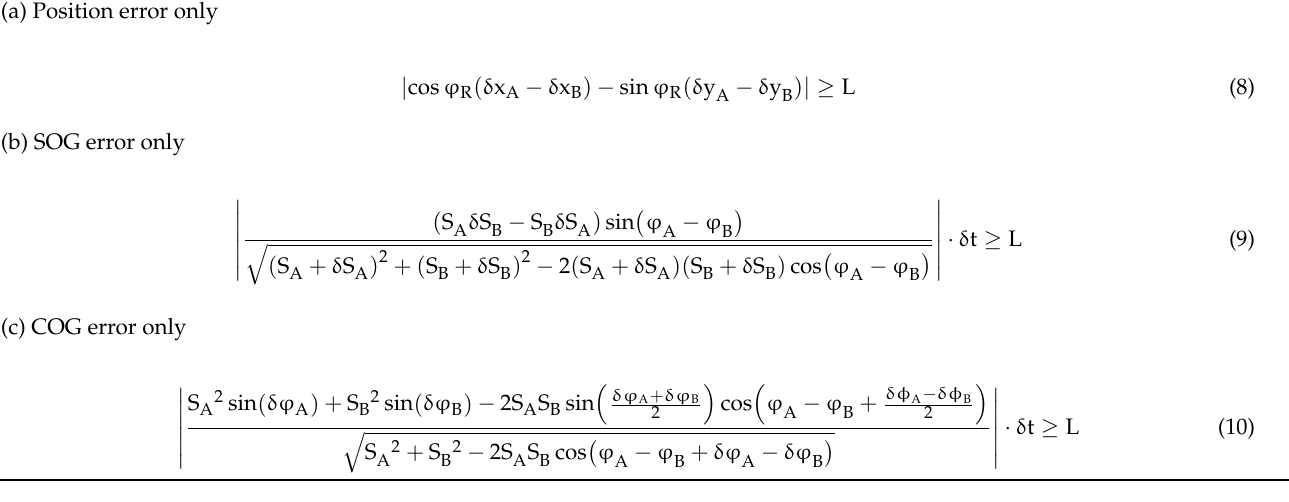
Table 1. Conditions at which individual errors may result in dangerous misinterpretation of an existing collision